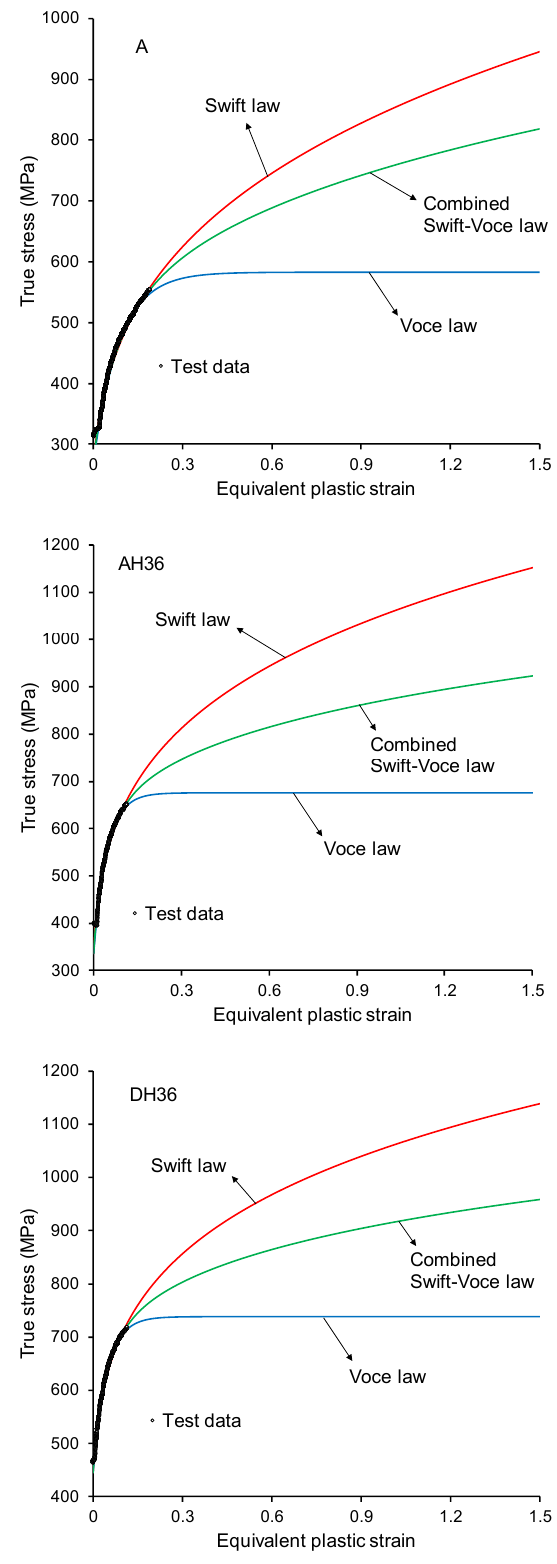
Figure 10. Calibrated strain hardening curves of A, AH36 and DH36 steel